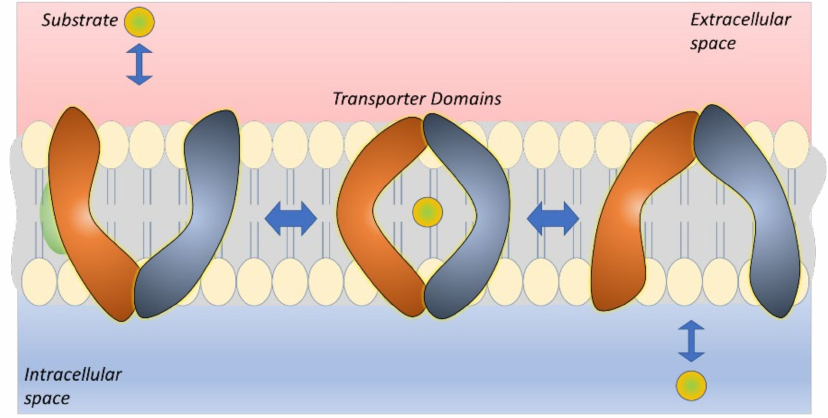
Figure 5. The rocker switch transport mechanism of GLUT1 and 3. The substrate (green ball-shape) is bound to the V-shaped transporter (outward-open state) on the extracellular side of the plasma membrane. The conformational movements of the transporter domains (orange and blue banana- shapes) trigger outward-occluded and inward-occluded states (only one state is showing). Finally, the substrate is released from V-shaped inward-open conformation to the cytosolic